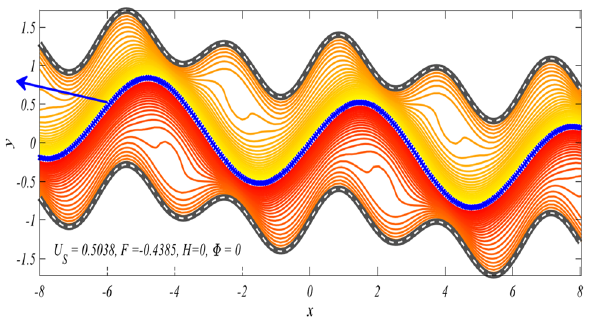
Figure 16. Impact of magnetic field on